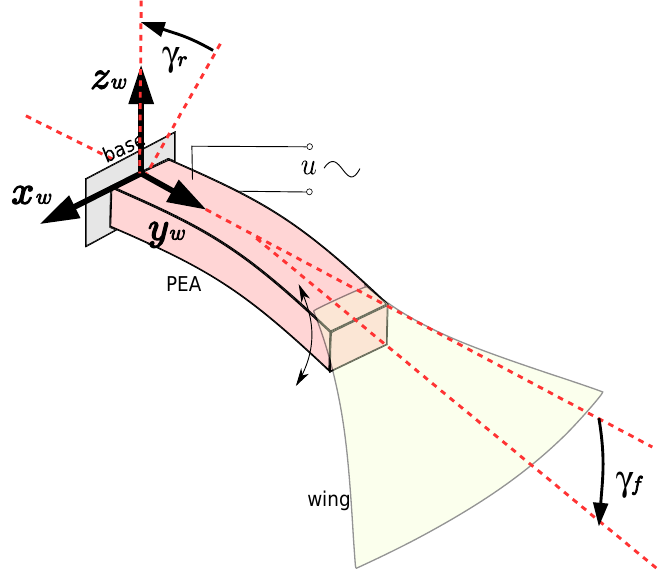
Figure 10. Perspective Piezowing: the PEA actuates directly to flap microrobot’s wing. The flapping angle and wing’s lift attitude respectively stand for γ f and γ r . The latter angle is generated by a PEA-based joint located at Piezowing’s